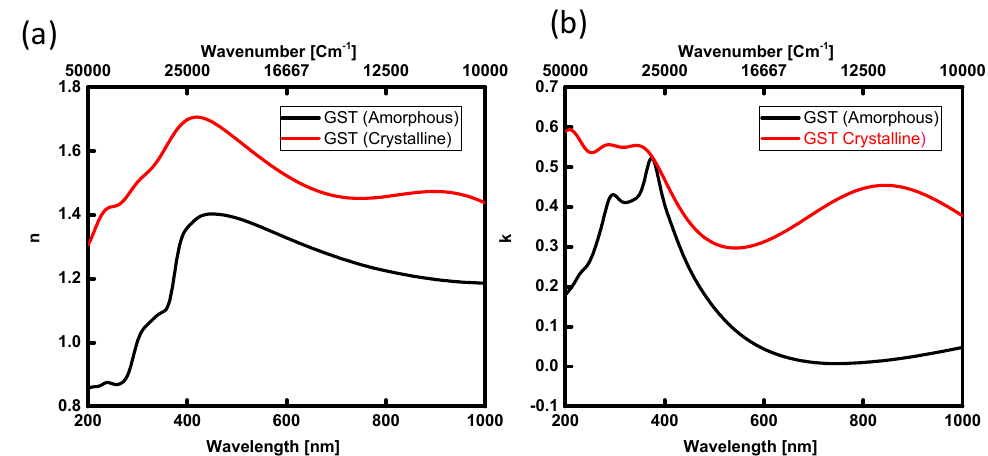
Figure 3. Dielectric constant ( a ) n and ( b ) k in the 200 ≤ λ ≤ 1000 nm wavelength range for the amorphous and crystalline phases of Ge 2 Sb 2 Te 5 , obtained from ellipsometry data.